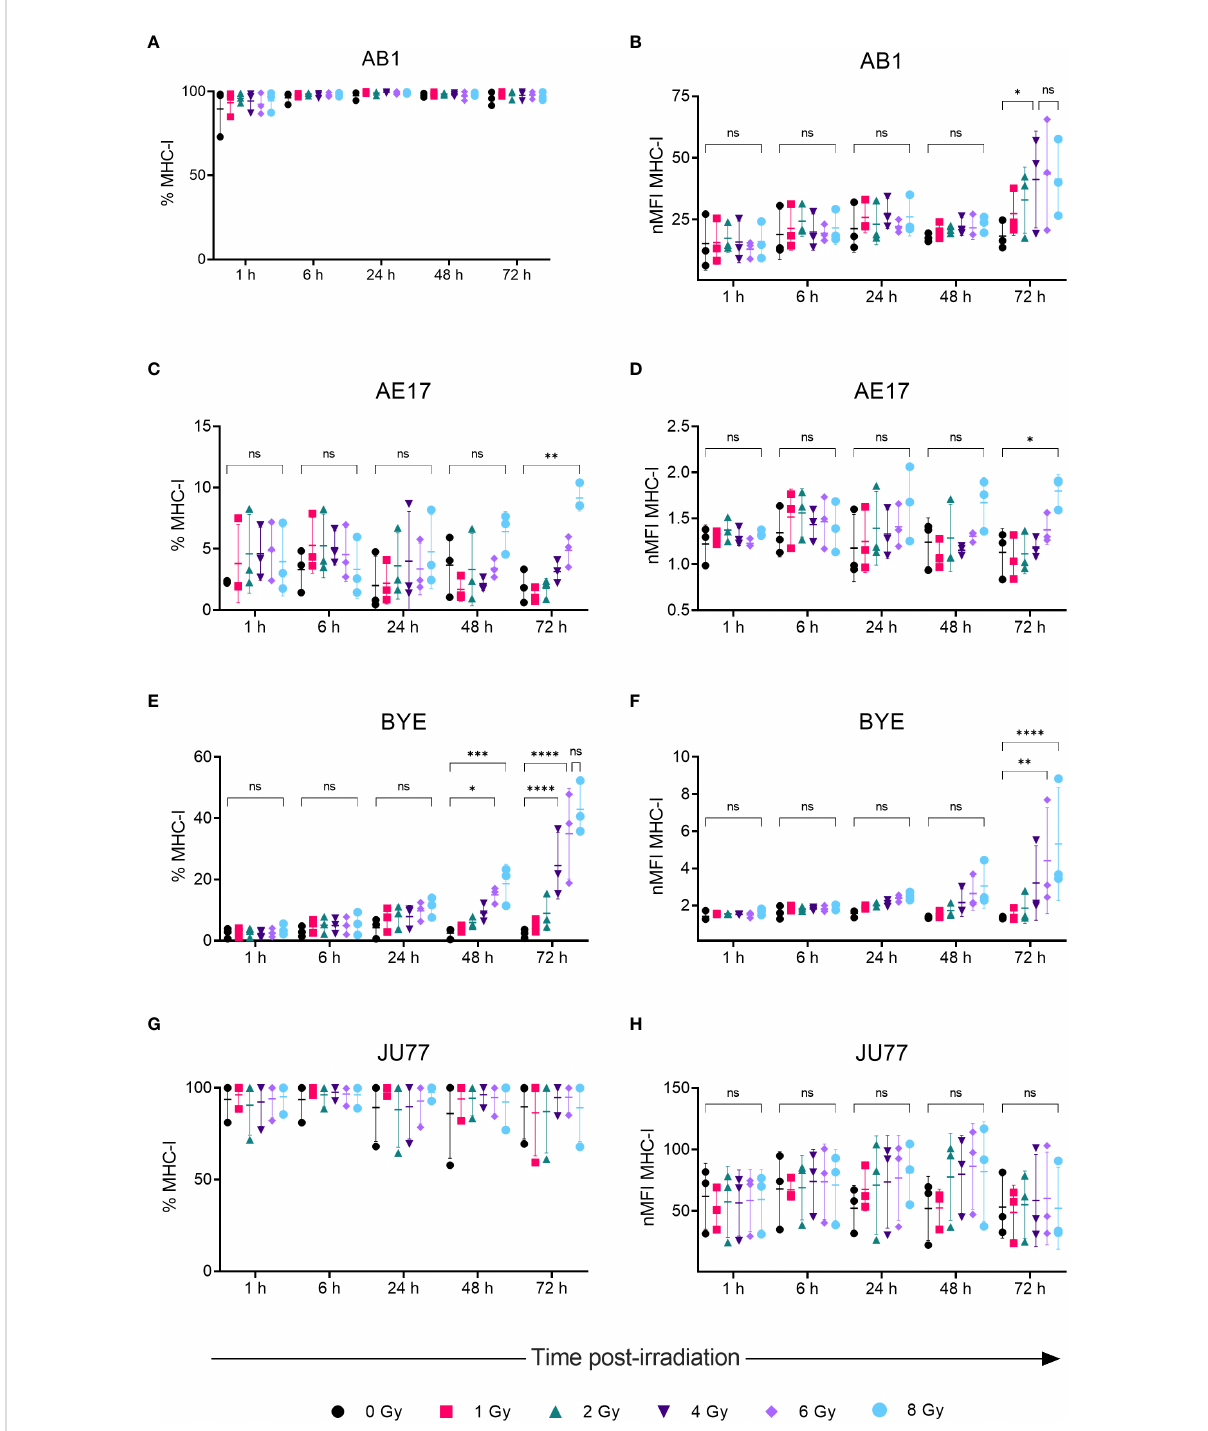
FIGURE 2 Radiation increases MHC-I expression on mesothelioma cells in a dose- and time-dependent manner. (A – H) Mesothelioma cells were irradiated with 0-8 Gy and changes to the percentage of MHC-I positive cells and nMFI over time (1, 6, 24, 48 and 72 h) were determined by fl ow cytometry for AB1 (A, B) , AE17 (C, D) , BYE (E, F) and JU77 (G, H) cell lines. Data are presented as mean ± S.D. of n = 3 independent experimental repeats. All p-values were determined by two-way ANOVA and multiple pairwise comparison with Tukey adjustment. P-values are represented as follows: * p < 0.05, ** p < 0.01, *** p < 0.001, **** p < 0.0001. ns, not signi fi